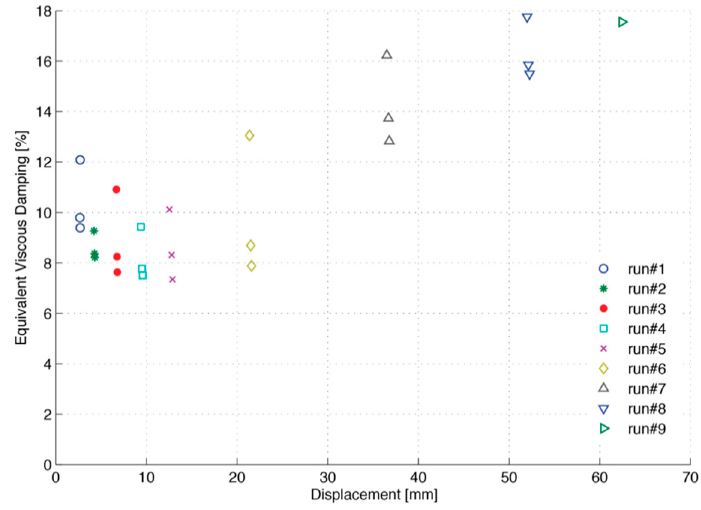
Figure 23. Force-displacement loop of the structure, envelope curve, and bilinear approximation.